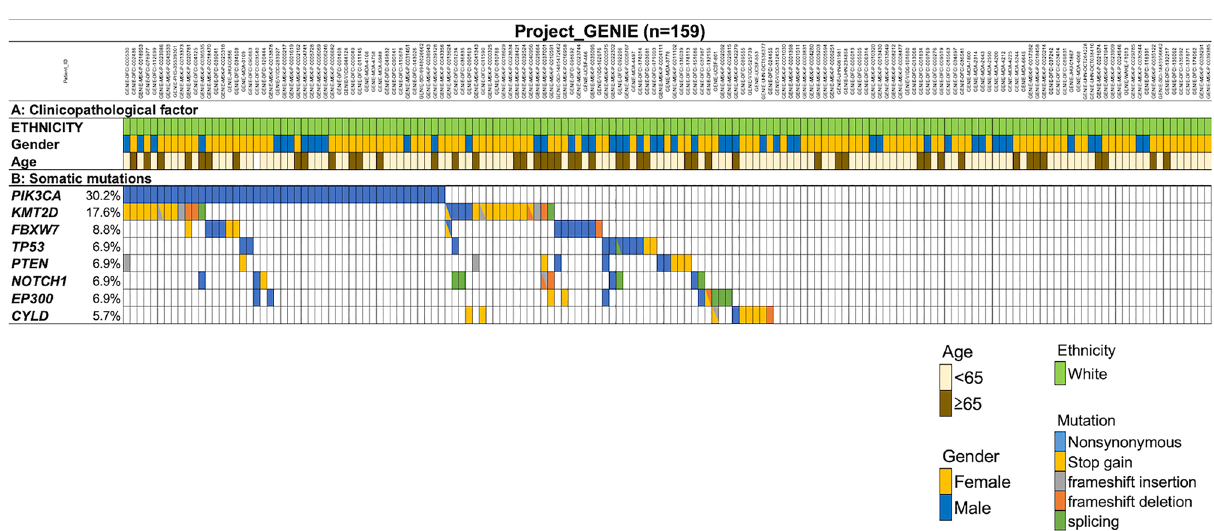
Figure 2. Profile of genomic alterations of patients with ASCC registered in GENIE. All panels are aligned with vertical tracks representing 159 individuals. ( a ) Patient characteristics. ( b ) Distribution of somatic mutations of patients with ASCC in GENIE. ASCC, Anal squamous cell